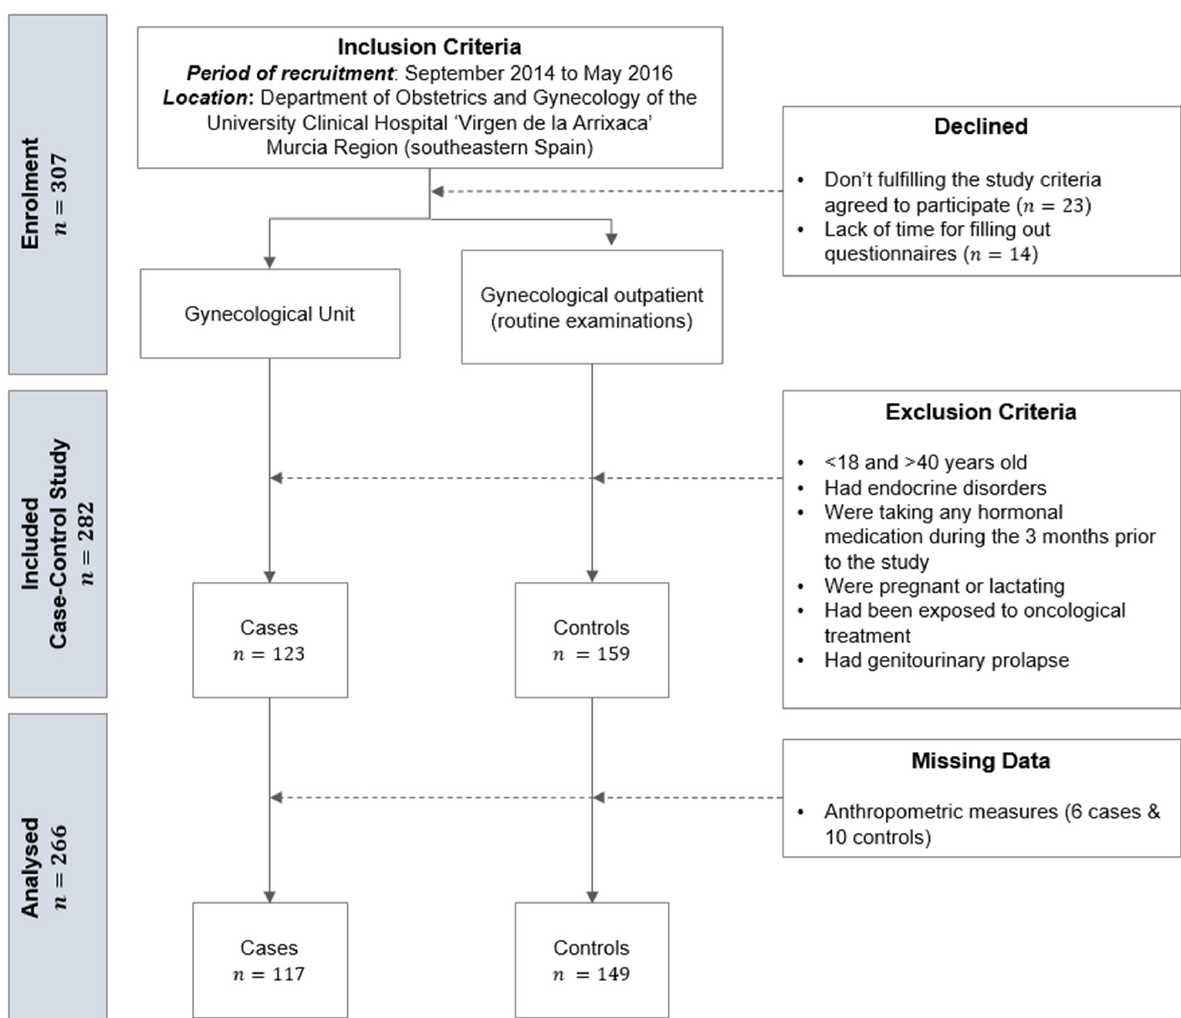
Figure 1. Flow diagram of numbers of women at each stage of